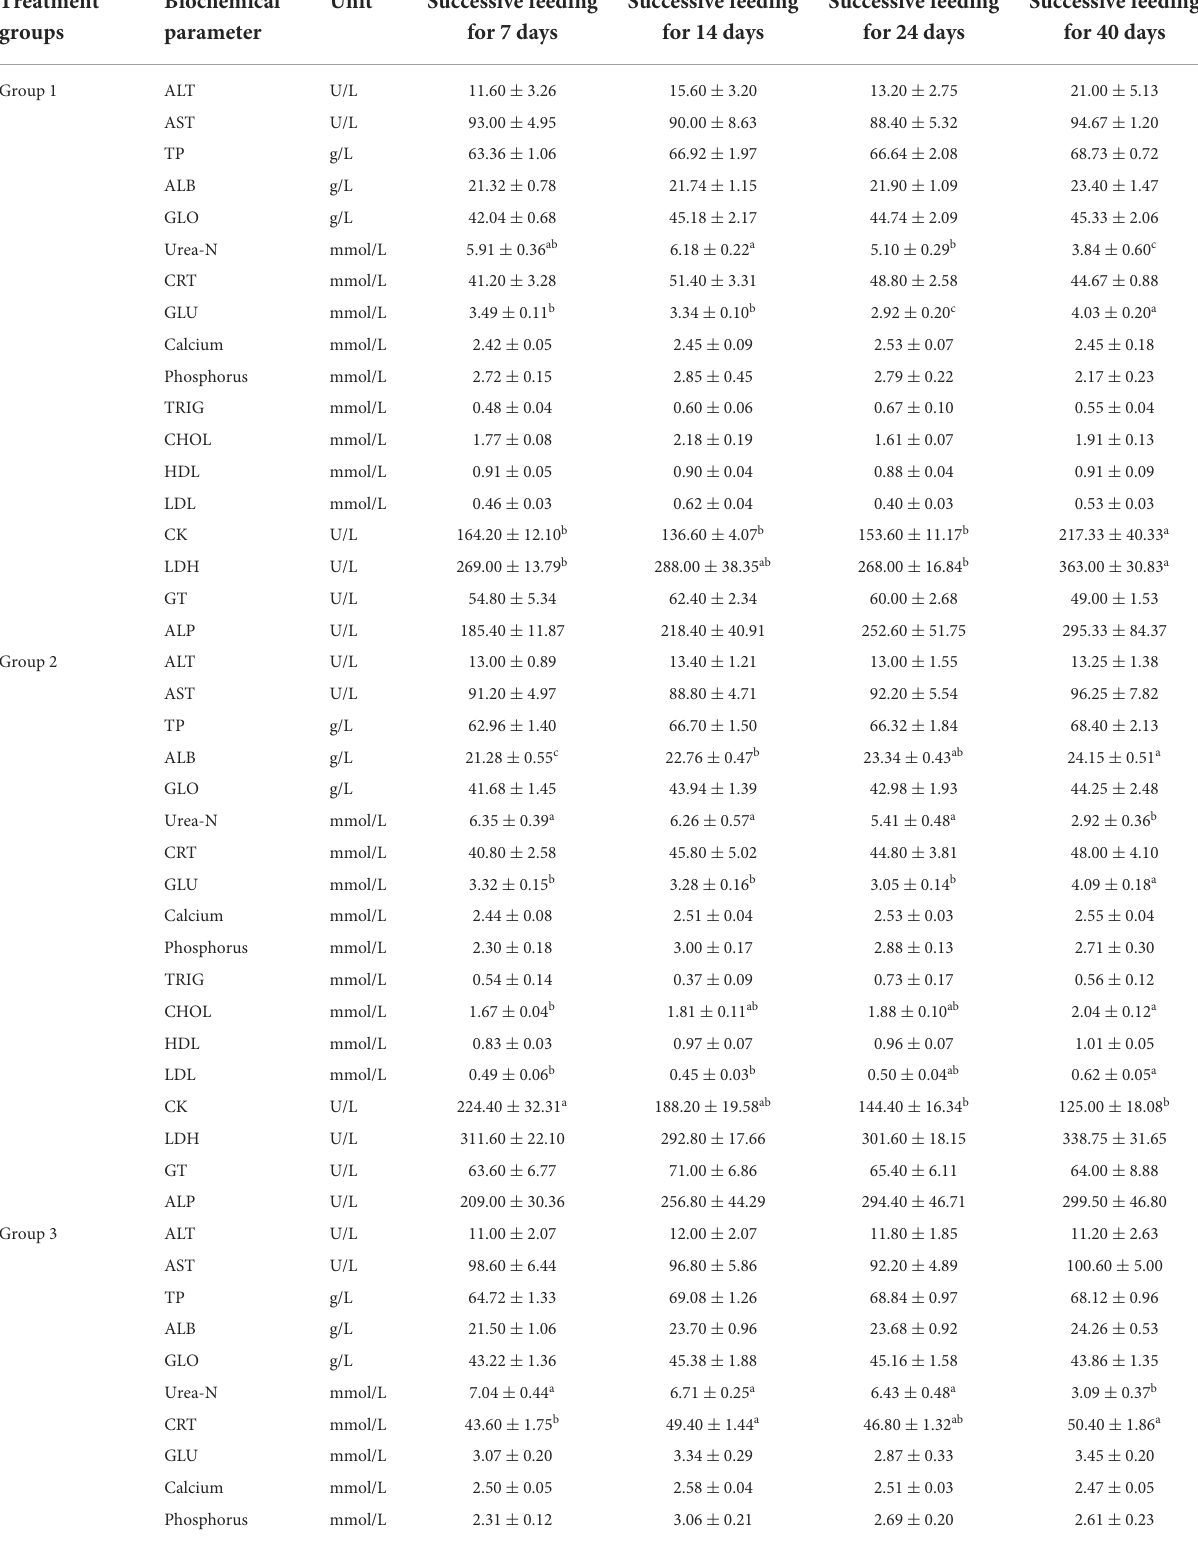
TABLE 5 Comparisons of serum biochemical parameter levels (mean ± SE) at different sampling time points in four groups ( n = 5).